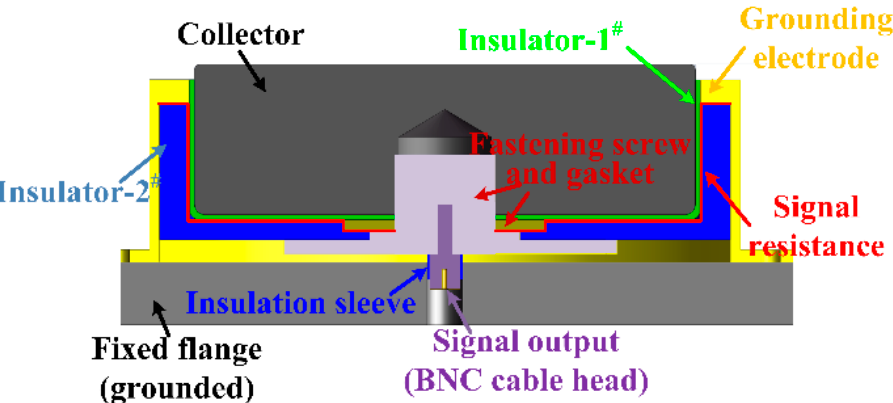
Figure 2. Structural diagram of the fast time full absorption Faraday cup. The small signal resistor structure is shown in Figure 3. A 45 µ m-thick constantan foil was used to prepare the signal resistor by cutting. The amplitude of the signal resistor was adjusted by controlling the number of parallel lines and the structure on each current